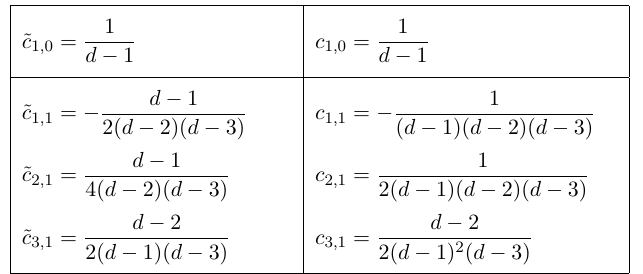
~ c 1 ; 0 and c 1 ; 0 are read from eq. (2.49) and eq. (2.51). ~ c i; 1 is the coe(cid:14)cient